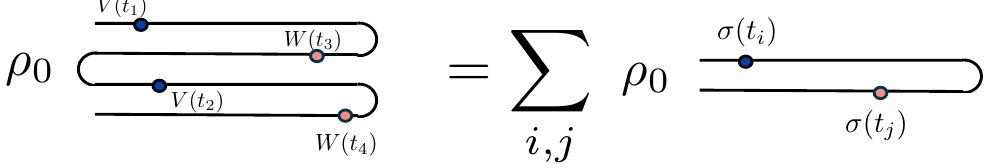
Figure 3 . At leading order in large N OTO four-point functions defined on a four-contour reduce to a sum of two-point functions of σ ( t ) . They can therefore be calculated from the effective action of the hydrodynamic field σ on a CTP